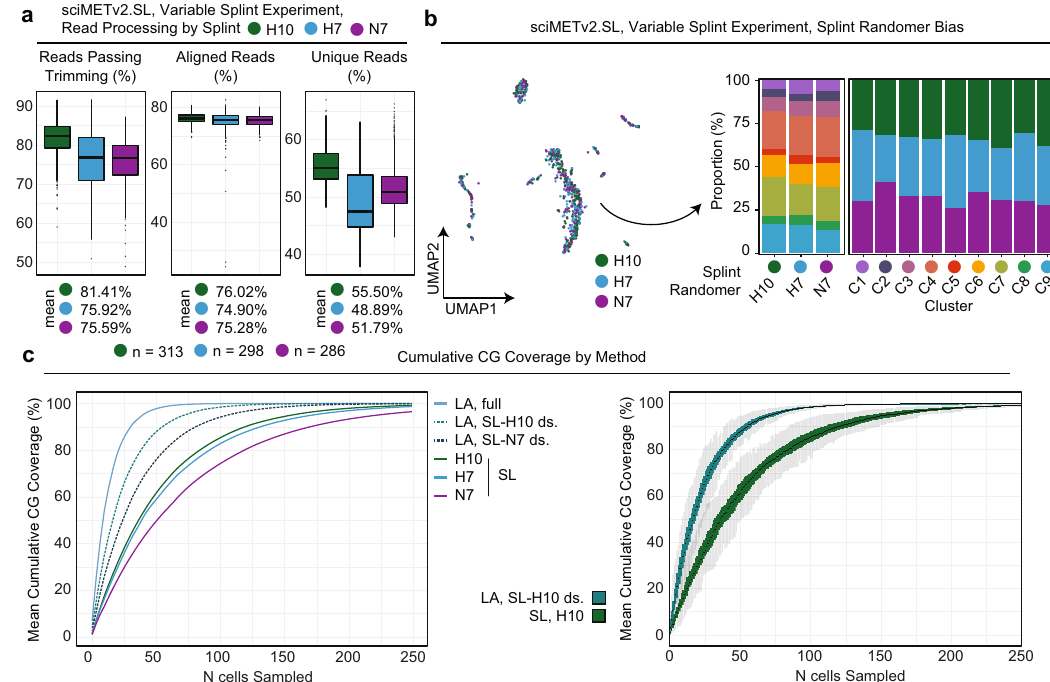
Fig. 3 | sciMETv2 splint ligation optimization and performance. a Read pro- cessingandretentionbrokendownbythethreesplintdesignsinthevariablesplint sciMETv2.SL experiment. For all boxplots, boxes indicate median, 25th and 75th percentiles with min and max lines as 1.5x interquartile range. b UMAP colored by variable splint (left) and composition of clusters by splint and splint by clusters (right). c Cumulative coverage from sampled cells for each method over 100